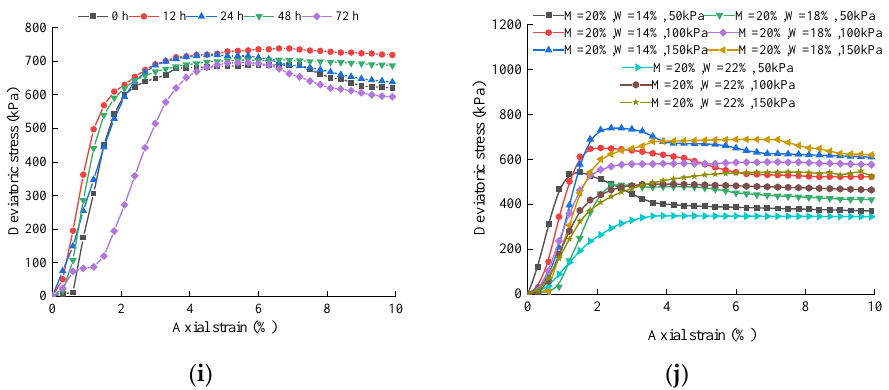
Figure 7. Principal stress difference axial strain curves of lime soil: ( a ) M = 10%, W = 18%, 50 kPa; ( b ) M = 10%, W = 18%, 100 kPa; ( c ) M = 10%, W = 18%, 150 kPa; ( d ) M = 15%, W = 18%, 50 kPa; ( e ) M = 15%, 100 kPa; ( f ) M = 15%, W = 18%, 150 kPa; ( g ) M = 20%, W = 18%, 50 kPa; ( h ) M = 20%, W = 18%, 100 kPa; ( i ) M = 20%, W = 18%, 150 kPa; ( j ) T = 0 h, M = 20%.